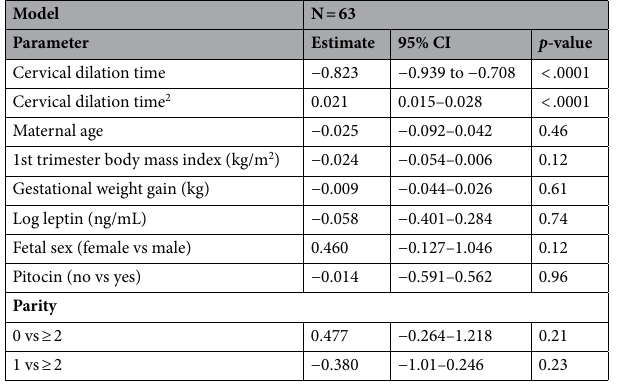
Table 5. Generalized estimating equations model assessing the effect of log of leptin and potential confounding variables on cervical dilation over